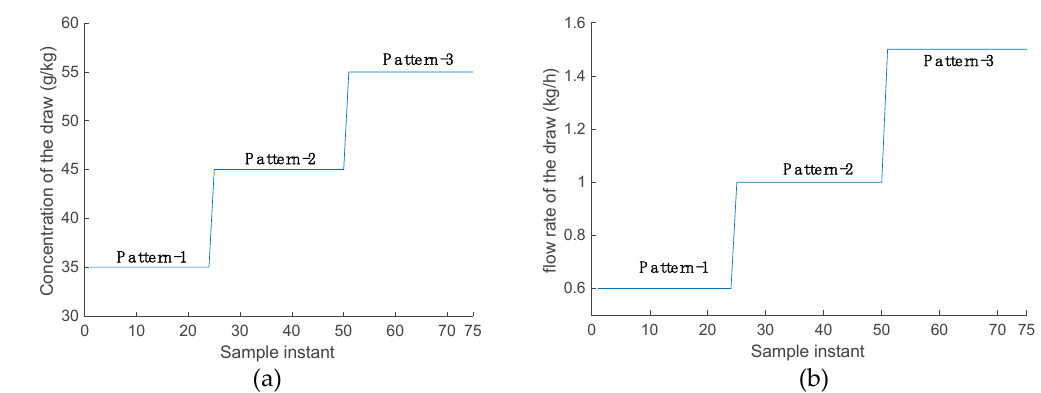
Figure 4. Operational profiles of the salinity in the PRO system in scenario 2: ( a ) concentration of the draw solution; ( b ) flow rate of the draw solution